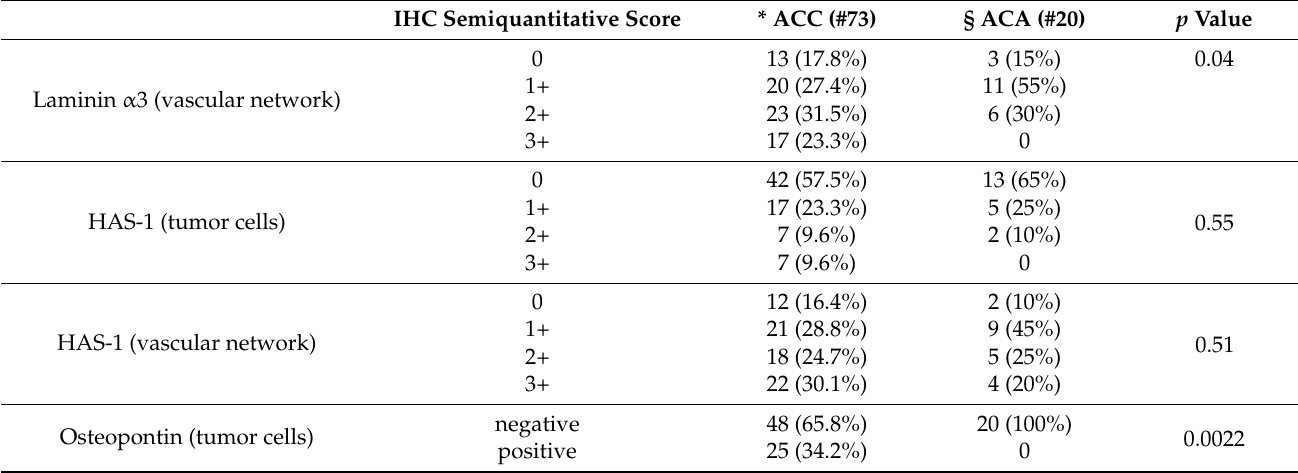
Table 2. Immunoexpression of Laminin α 3, HAS-1 and osteopontin in a series of 73 adrenocortical carcinomas and 20 adrenocortical adenomas.